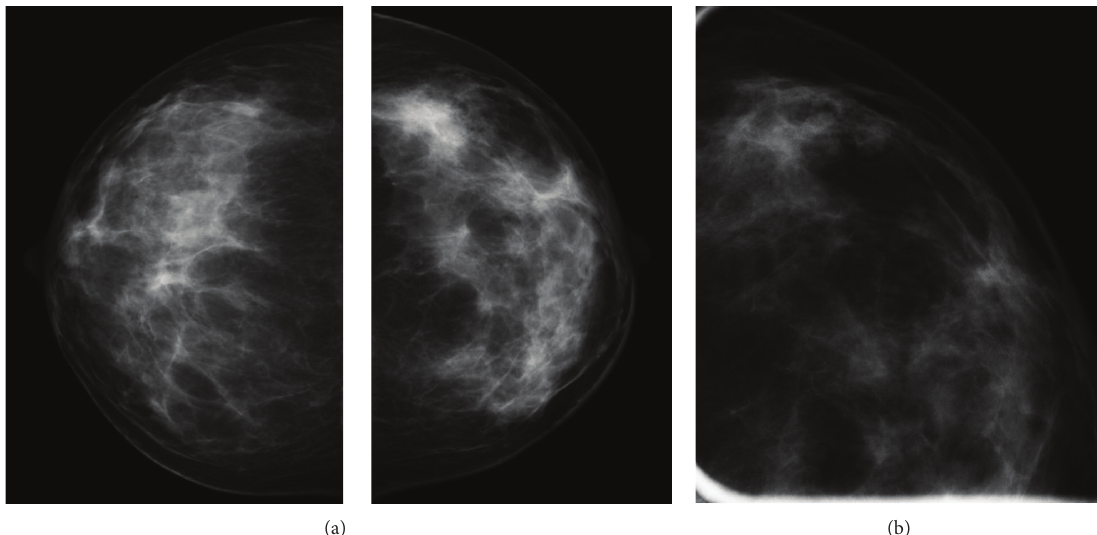
Figure 1: Bilateral craniocaudal projection (a) and magnification view (b) show an asymmetrical increased density in the lateral quadrants of the left breast.